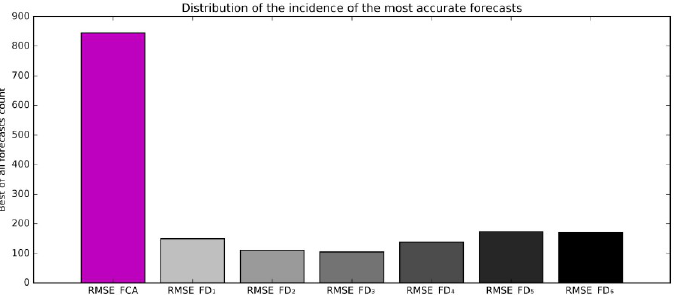
Figure 15. In the far majority of cases, FCA is the best compared to successive ALADIN